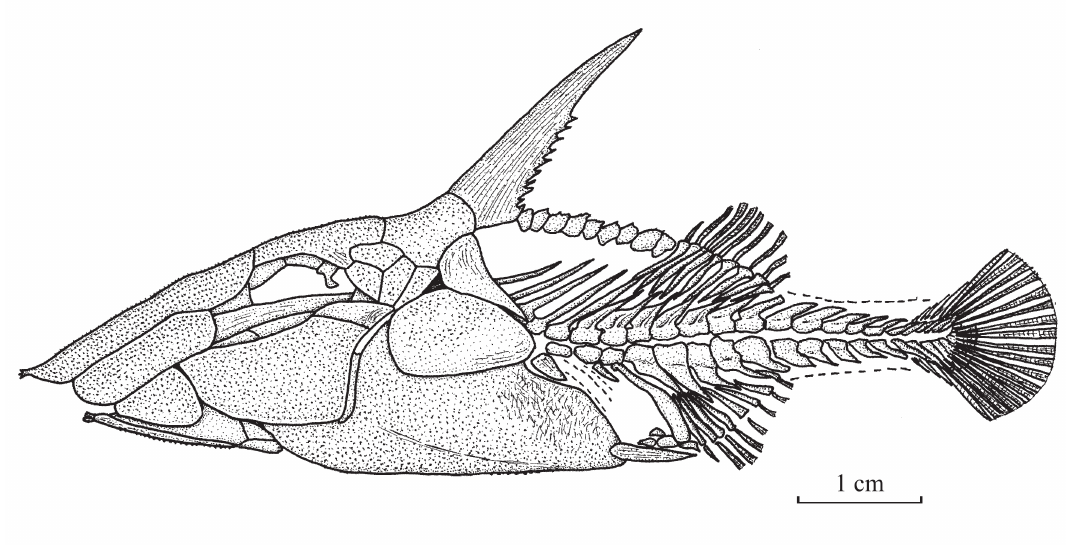
Fig. 4. Joinvillichthys lindstroemi (Davis, 1890). General reconstruction based on holotype, NRM PZ P. 2073 and samples IRSNB N° P 9276, CLC S-138 and CLC S-324. The scale refers to sample CLC S-138.